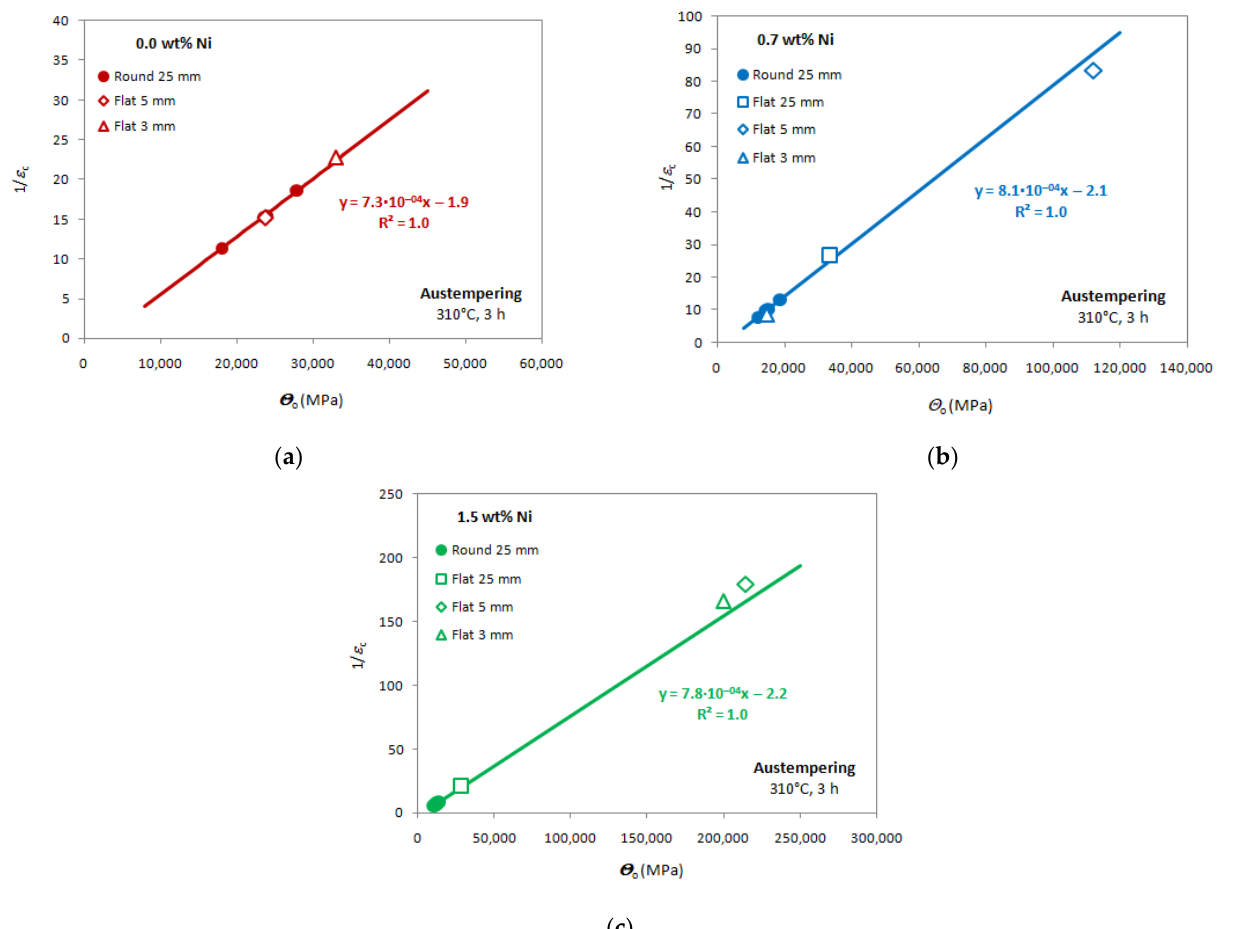
Figure 14. MADs for 25 mm Y-block ADIs (round and tensile specimens), 5mm and 3mm thin castings with austempering conditions 310 °C and 3 h with different Ni content: ( a ) nominal 0.0 wt% Ni; ( b ) nominal 0.7 wt% Ni; ( c ) nominal 1.5 wt% Ni.